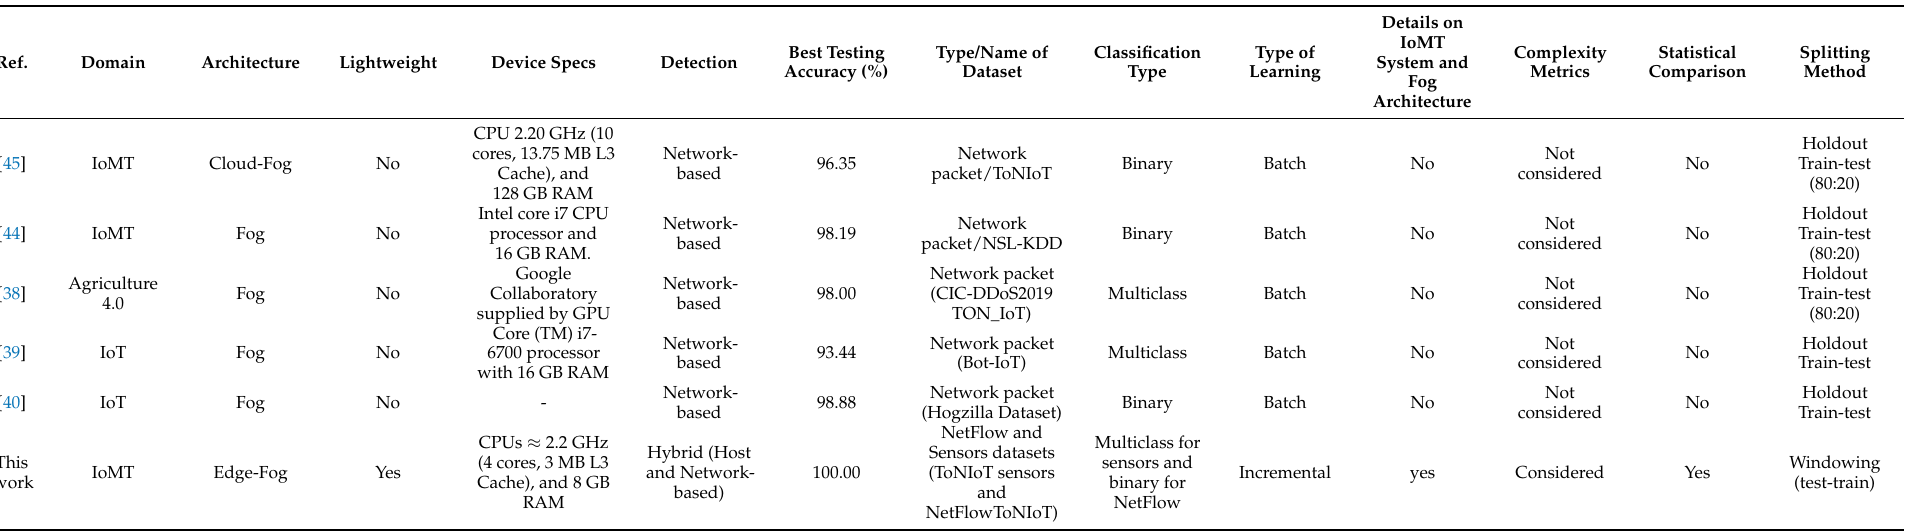
Table 8. The comparison between the main results of this study and those reported in the